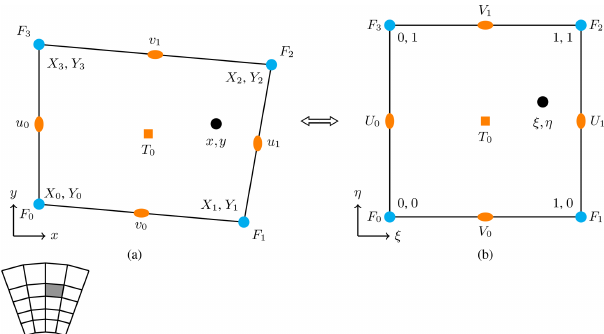
Figure 3. Positioning of the variables for an A grid (blue nodes) and C grid (orange nodes) cell with (a) physical coordinates in the mesh cell and (b) relative coordinates in the unit